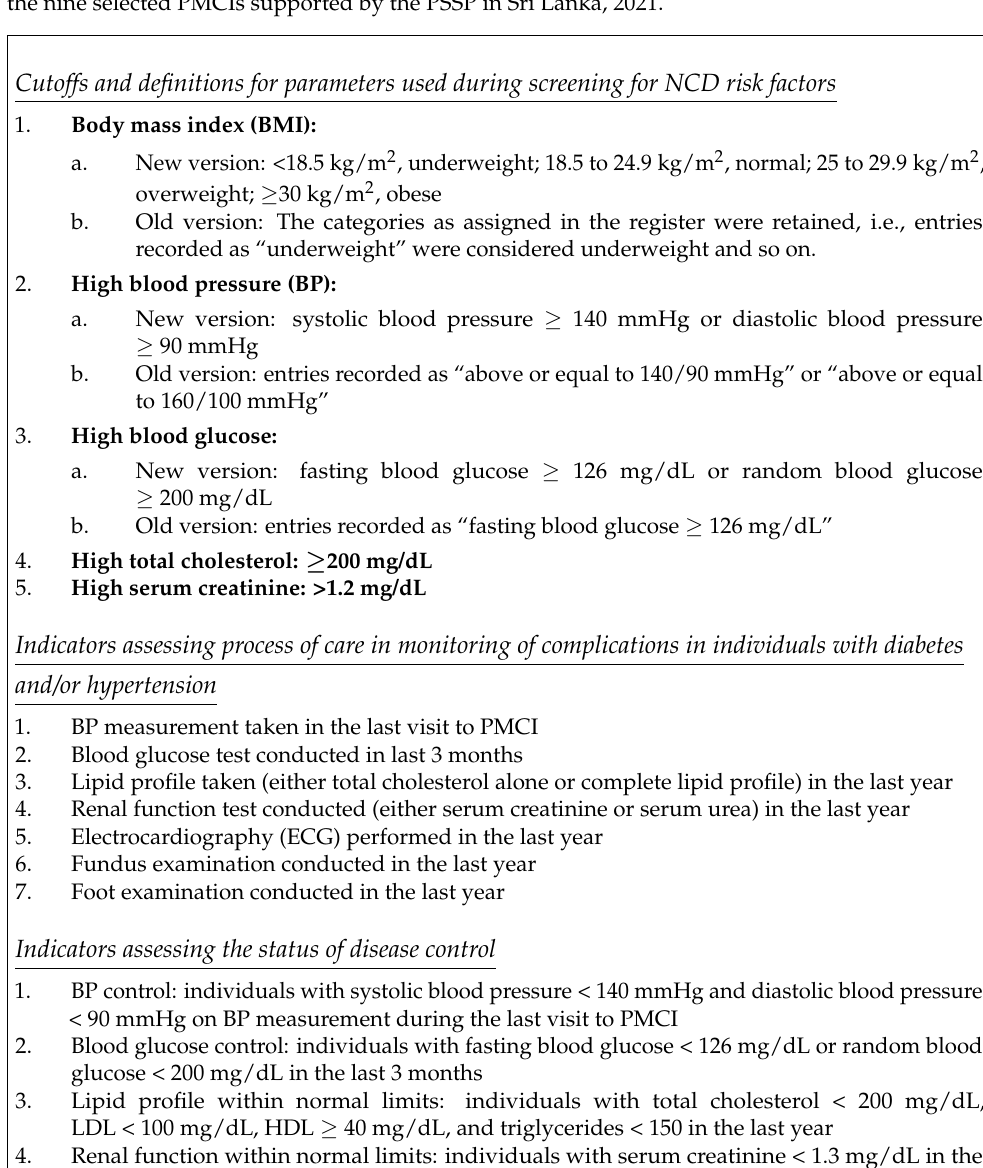
the nine selected PMCIs supported by the PSSP in Sri Lanka,